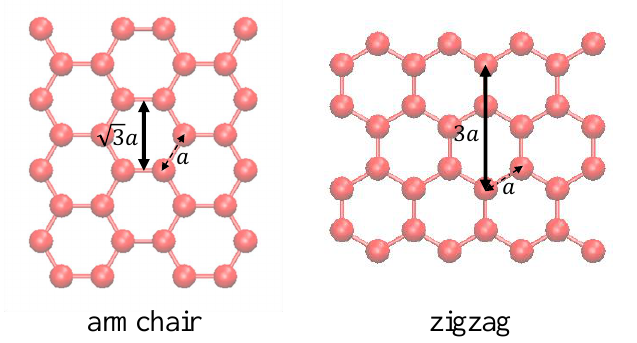
Figure 6. Periodic dimension in the axial direction related to the determined internal length parameter for zigzag and armchair CNTs, “a” is the carbon-carbon bond ∼ 1.42